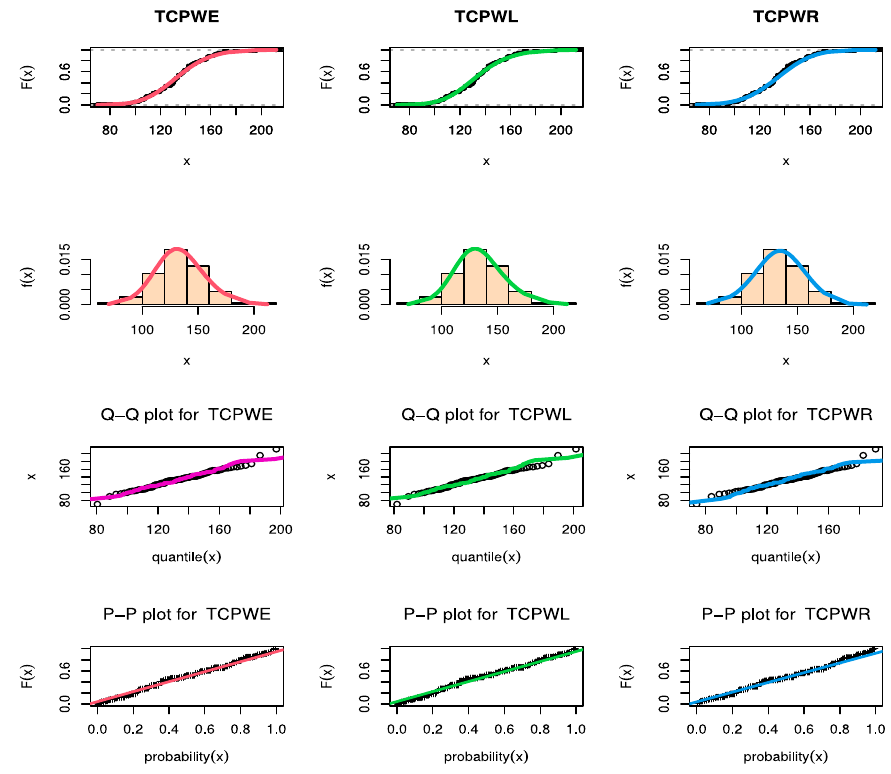
Figure 10. The estimated CDF, fitted PDF, PP-plot, and QQ-plot of the TCPWE and TCPWL and TCPWR distributions for fatigue times.